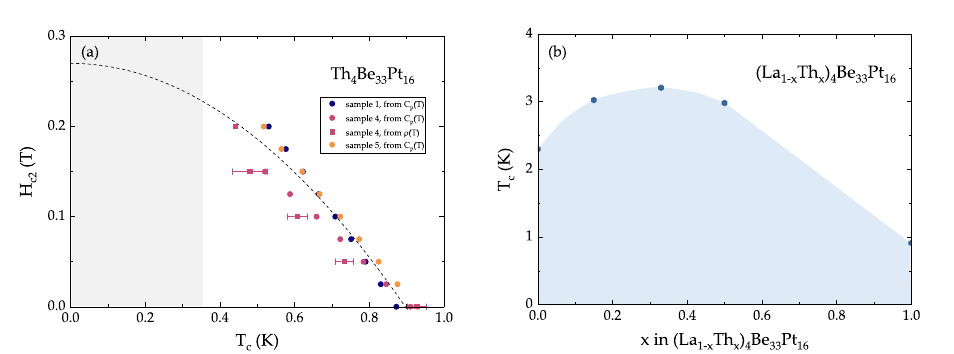
Figure 5. Evolution of superconducting properties in Th 4 Be 33 Pt 16 as a function of a tuning parameter. ( a ) The H – T phase diagram of Th 4 Be 33 Pt 16 . The dashed black line corresponds to the Ginzburg–Landau fit of the data, while the red line is a linear fit around T c needed for the WHH extrapolation. ( b ) The value of the superconducting critical temperature T c as a function of x in (La 1 − x Th x ) 4 Be 33 Pt 16